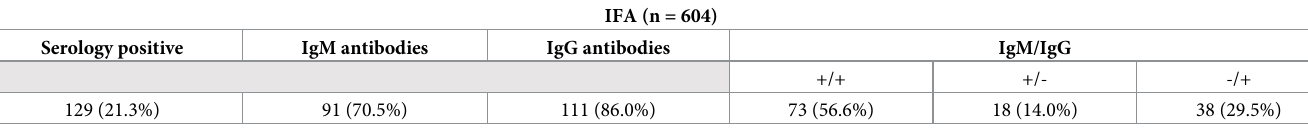
exposure (seropositivity), acute disease, and chronic disease, respectively, together with the presence of anti-phase II and anti-phase I antibodies in the sera. The presence of anti-phase II together with a cut-off of 128 was correlated with acute disease, and the presence of anti-phase I with a cut-off of 1024 or higher was considered a chronic disease. The results are shown in Table 3. Of the 46 seropositive patients by commercial immunofluorescence test, 29 (63%) had phase II antibody titers higher than 128 and were therefore defined as having acute Q fever. suggesting that these patients had a persistent infection. A 60-year-old woman, symptomatic for more than 14 days, had an extremely high titer of 32.768 for both phases. Table 4 presents the results of the serological analyses according to the variables collected: days of symptoms, age, sex, and size of the municipalities classified as rural, small, medium, and large. The table shows the seropositive and seronegative patients, total population, and